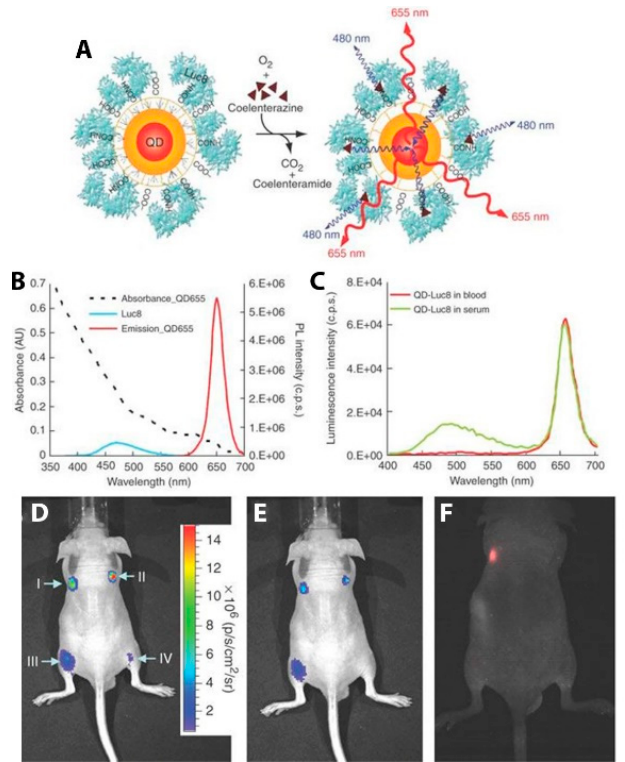
Figure 12. In vivo BRET-based imaging of labeled C6 glioma cells in mice. ( A ) Schematic of a QD covalently coupled to the BRET donor, RLuc8. The bioluminescence energy of RLuc8-catalyzed oxidation of coelenterazine is transferred to the quantum dots, resulting in QD emission. ( B ) Absorption and emission spectra of QD655 ( λ ex = 480 nm) and spectrum of the bioluminescent light emitted in the oxidation of coelenterazine catalyzed by RLuc8. ( C ) Bioluminescence emission spectrum of QD655-Luc8 in mouse serum and in mouse whole blood. ( D – F ) Bioluminescence and fluorescence imaging of QD655-Luc8 and Luc8 injected subcutaneously (I and II) and intramuscularly (III and IV) at indicated sites in a mouse (I and III, QD655-Luc8, 5 pmol; II and IV, Luc8, 30 pmol). ( D ) Bioluminescence image taken without filters. ( E ) Bioluminescence image taken with 575-650-nm filter. ( F ) Fluorescence imaging of the same mouse using 503–555 nm excitation filter. Adapted by permission from [26]. Copyright 2006, Springer Nature.